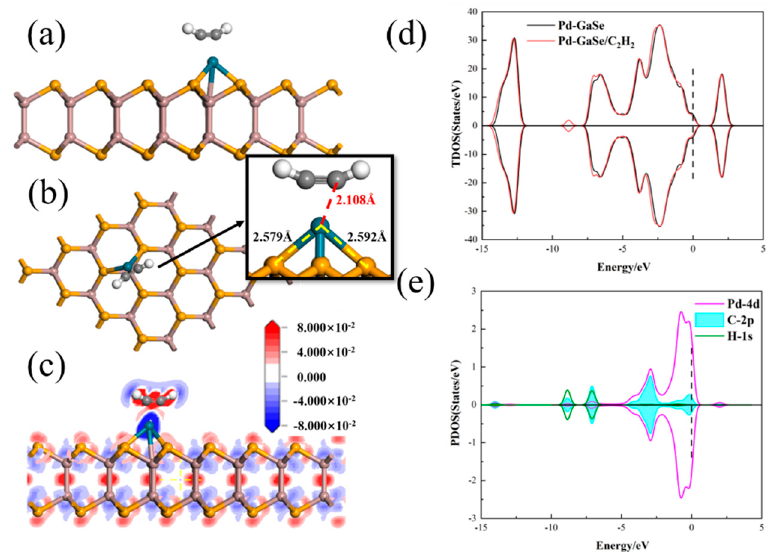
Figure 11. Adsorptive structure of Pd-GaSe/C 2 H 2 system ( a ) view of side, ( b ) view of top, ( c ) DCD distribution, ( d ) TDOS of Pd-GaSe/C 2 H 2 system, ( e ) PDOS of Pd-GaSe/C 2 H 2 system.